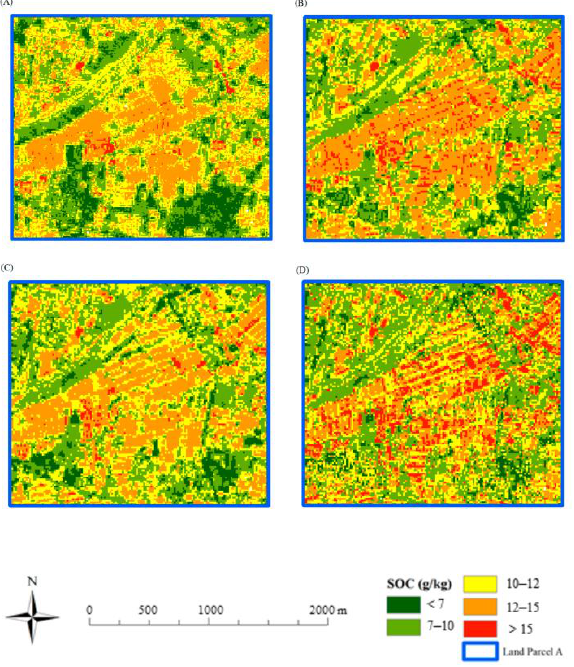
Figure 7. Spatial pattern of SOC in Land Parcel A based on ( A ) the ST model; ( B ) the STb model; ( C ) the STi model; ( D ) the STg model.